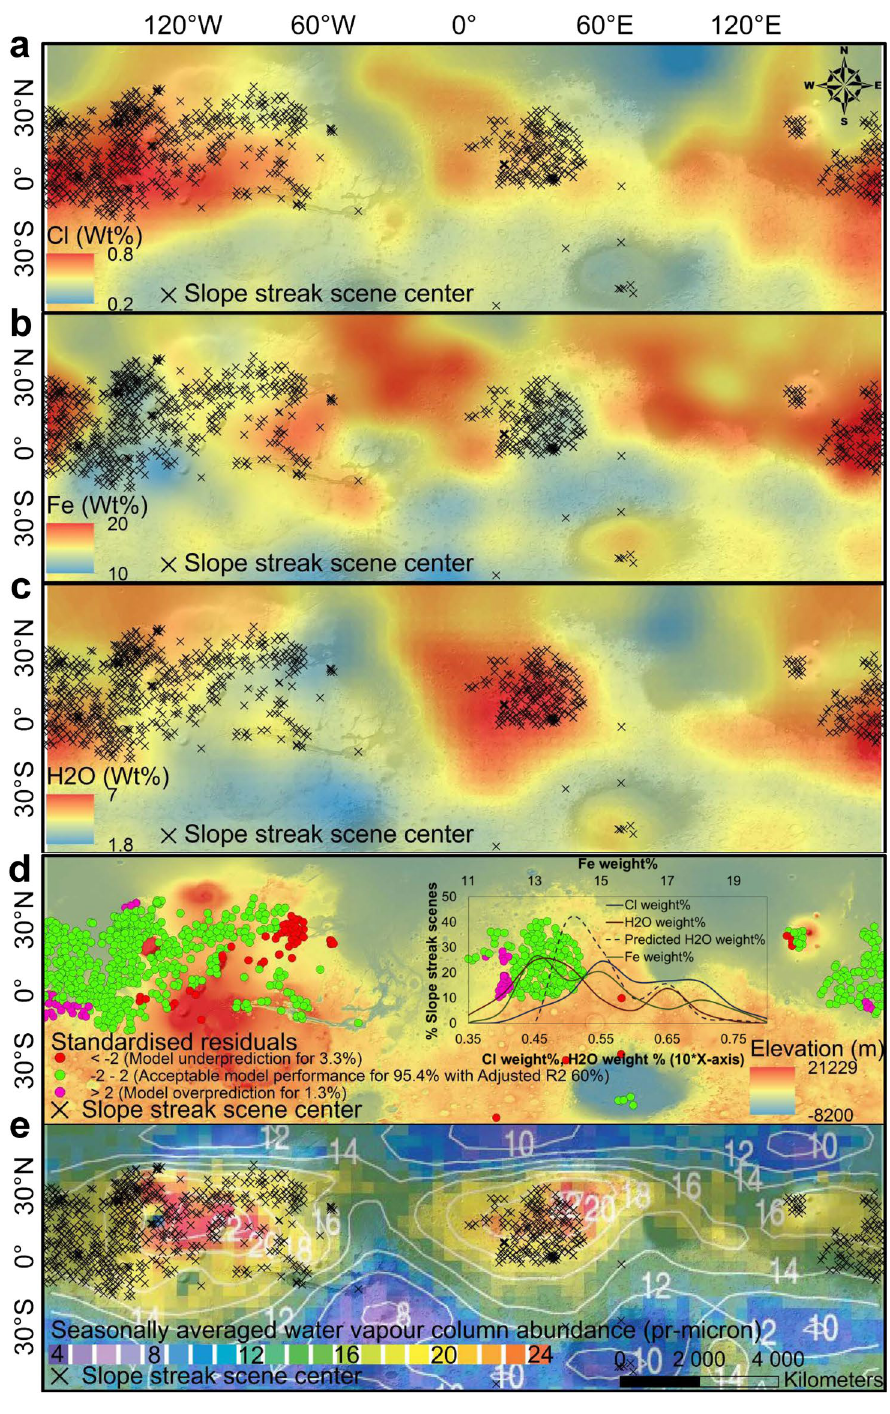
Figure 1. Global distribution of slope streaks and chemical parameters. ( a ) Cl concentration 30, 31 . ( b ) Fe concentration 31, 32 . ( c ) Water-equivalent hydrogen concentration 30, 31 . ( d ) Geographically weighted regression at the 95% confidence level 33 . The inset graph shows the % of SSR scenes in various concentration categories. ( e ), Mars Global Surveyor Thermal Emission Spectrometer (TES)-derived seasonally averaged water vapour column abundance after negating the effect of topography (modified Fig. 10 of Smith 34 ). The numbers and contours represent seasonally averaged water vapour column abundance in e. All of the weight% values given in a-c are taken from https://grs.lpl.arizona.edu/grs-web/specials/Smoothed_rebinned_map_data. Mars Orbiter Laser Altimeter (MOLA) elevation-derived hillshaded view is in the background of a-e. The Maps are created using ArcGIS Version 10.4 (http://desktop.arcgis.com/en/arcmap/latest/get-started/setup/arcgis-desktop-quick-